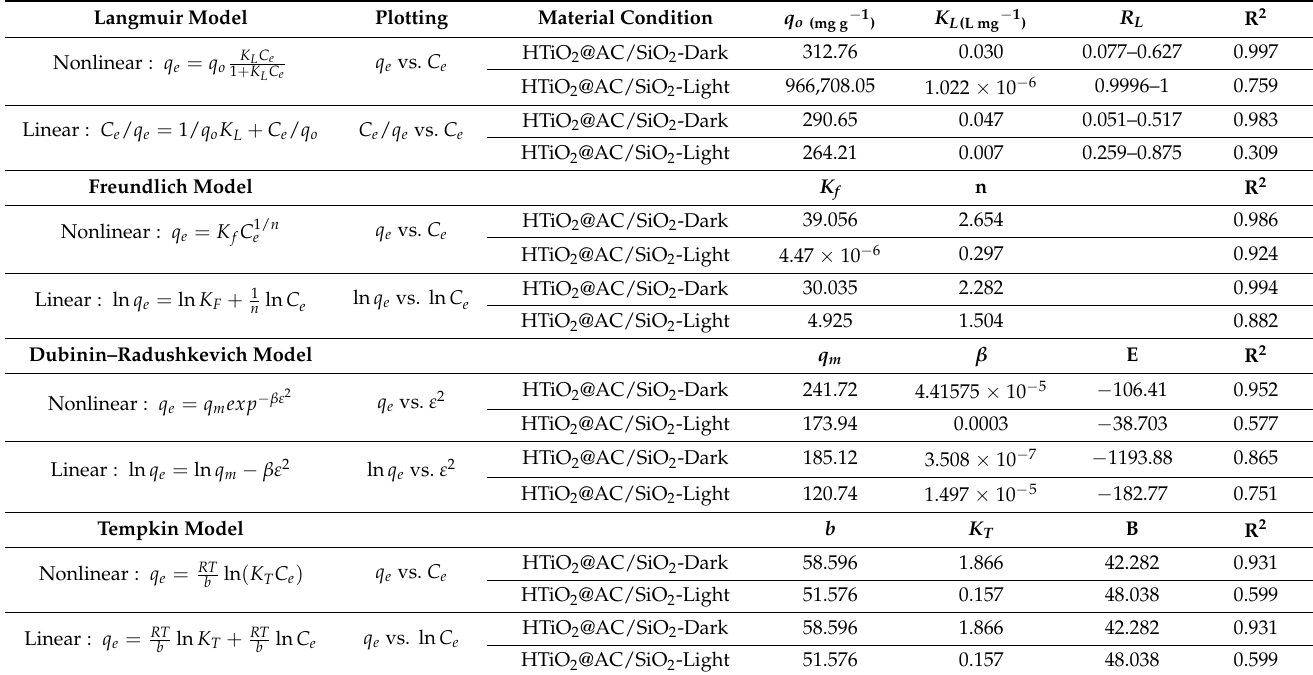
Table 1. Isothermal